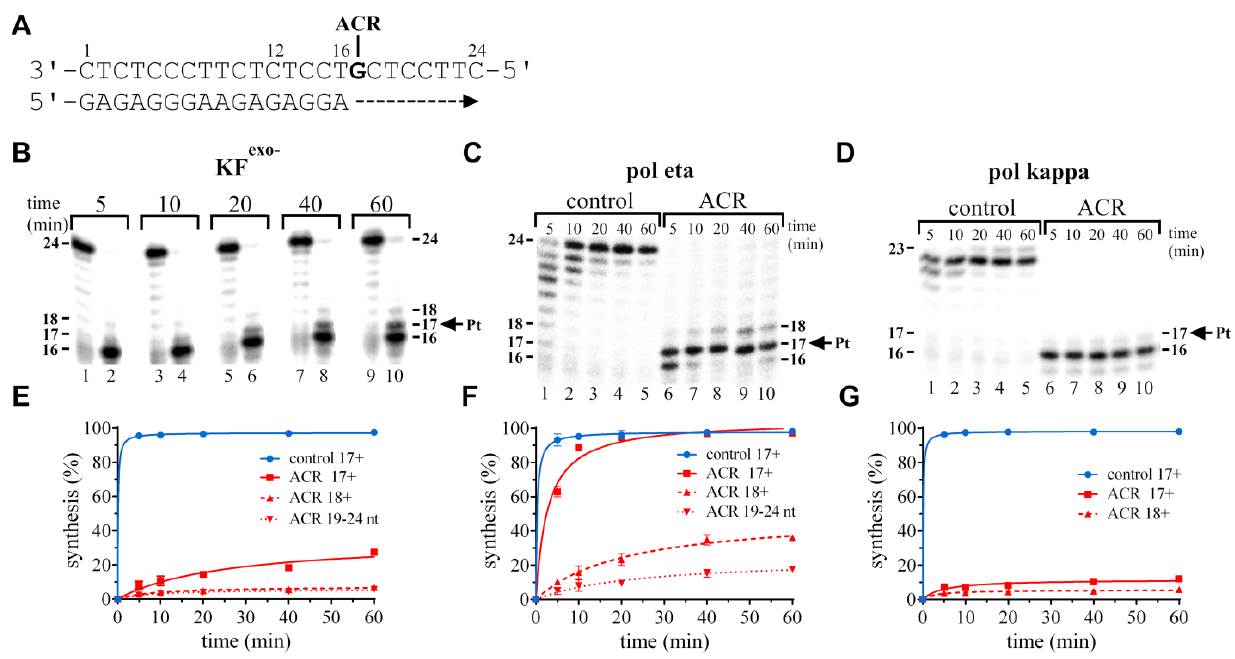
Figure 3. ”Standing-start“ translesion DNA synthesis by the exonuclease-deficient Klenow fragment of DNA polymerase I (KF exo − ), human DNA polymerase eta (pol η ), and human DNA polymerase kappa (pol κ ) on the 16-mer/24-mer primer/templates containing a single site-specific adduct of ACR in the presence of all the four dNTPs. The sequence of the primer/template duplex and the position of the platinated guanine is shown in panel ( A ). Primer extension activity of KF exo − ( B , E ), pol η ( C , F ), and pol κ ( D , G ). ( B – D ) Representative images of the DNA polymerase reaction products resolved on 15% polyacrylamide (PAA) gels. The experiments were conducted for the various times (timepoints of 5–60 min are shown above the gels) using the undamaged template (panel ( B ), lanes 1, 3, 5, 7, 9; panels ( C , D ), control lanes) and the template containing the ACR adduct (panel ( B ), lanes 2, 4, 6, 8, 10; panels ( C , D ), ACR lanes). The pause sites and the position of the platinated guanine (the intermediate lengths) are shown on the right or left side of the gels. ( E – G ) Densitometric evaluations of the intermediate accumulation during synthesis past undamaged or modified template; 17+, translesion synthesis past and behind the position of the adduct on the undamaged (control) template (blue circles and the solid line), a template containing ACR (red squares and the solid line); 18+, synthesis behind the ACR adduct (red triangles and the dashed line); 19–24 nt, accumulation of “full-length” nucleotide (nt) products behind the ACR adduct (red inverted triangles and the dotted line). The data are the means ( ± SEM) from three different